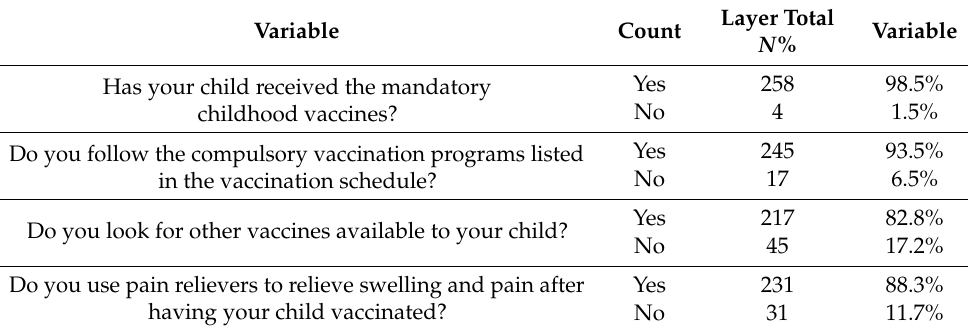
Table 4. Assessment of the mothers’ practice in relation to childhood vaccination ( N =